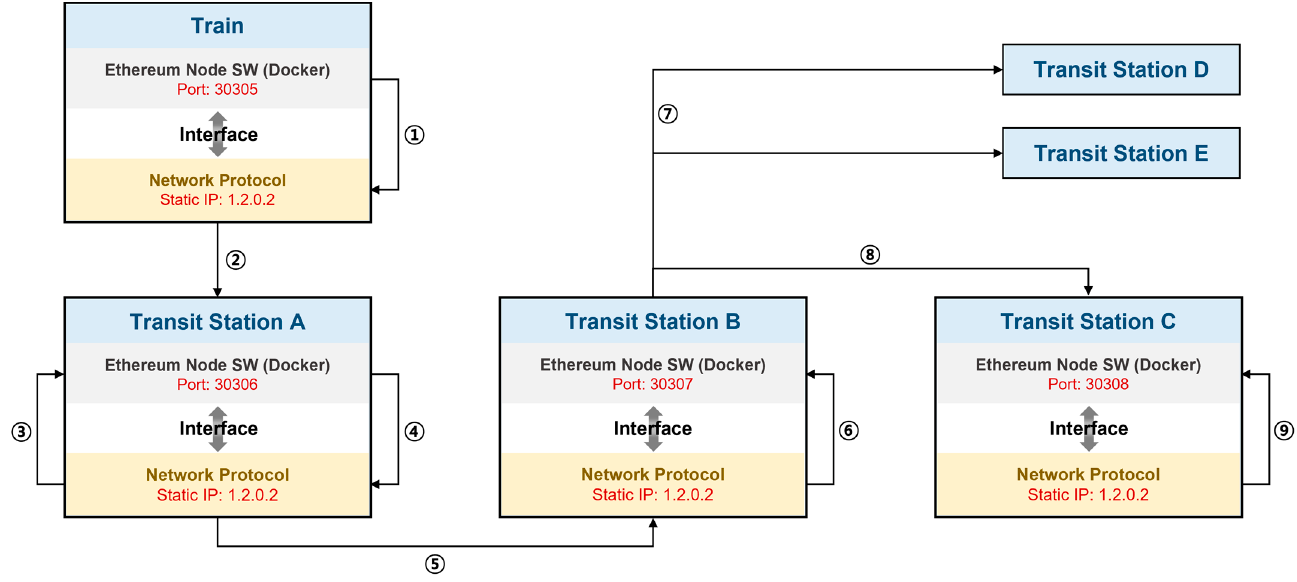
Figure 4. Non-stop customs clearance network implemented with Ethereum.